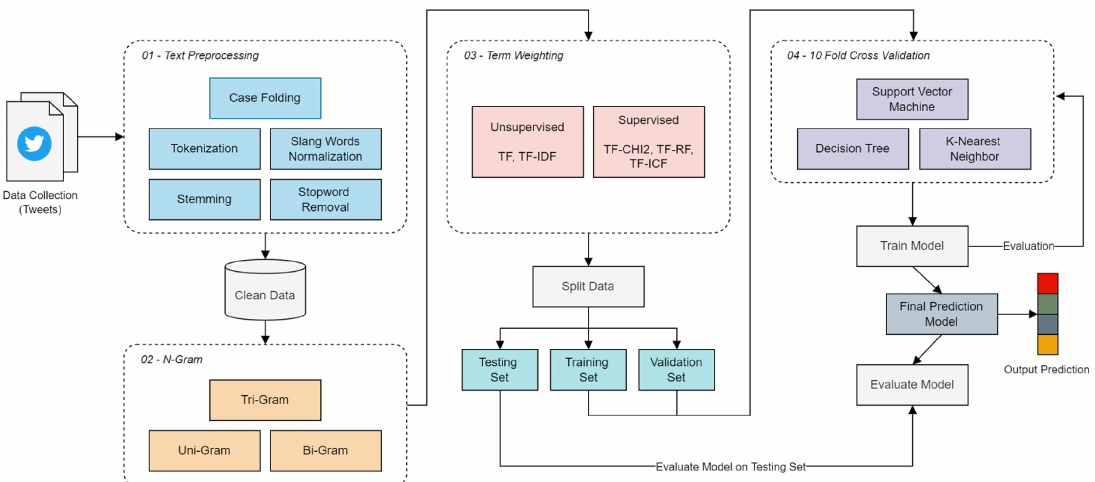
Fig. 1. Proposed research